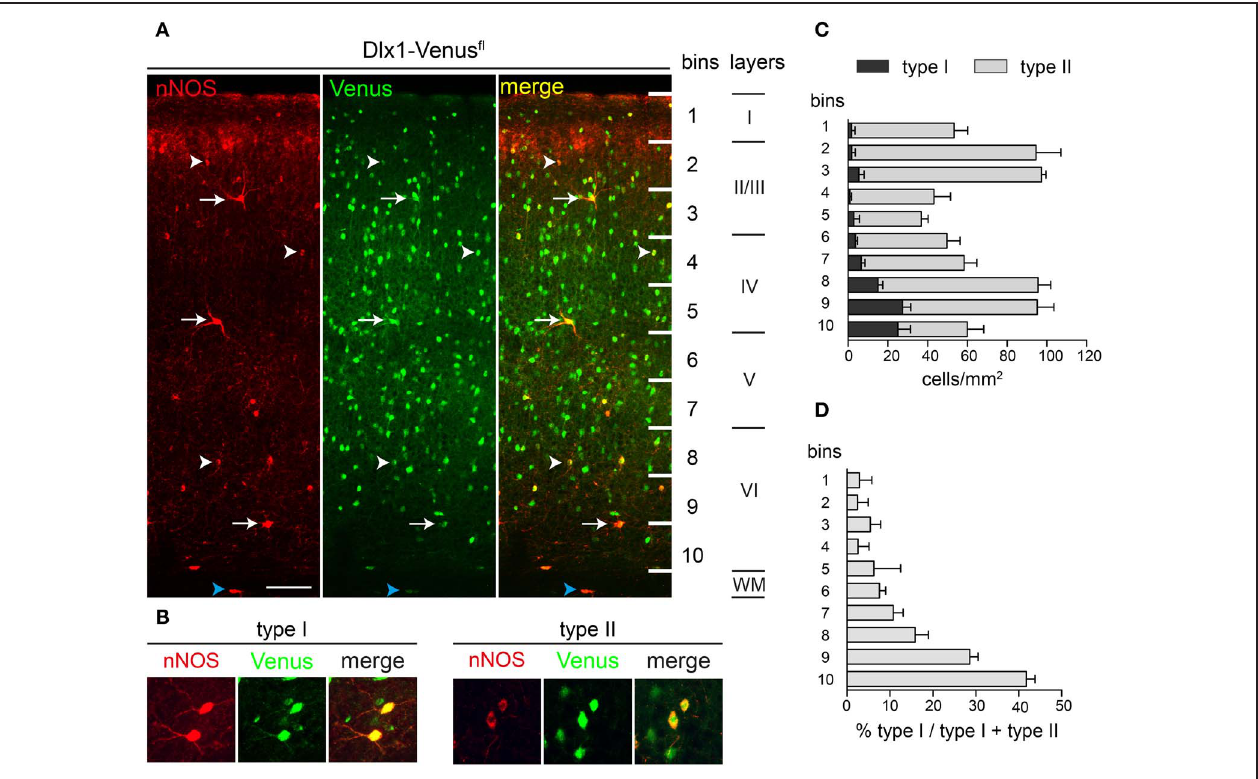
FIGURE 3 | nNOS-expressing type I and type II cells in the adult somatosensory cortex. (A) nNOS and Venus expression in the somatosensory cortex of Dlx1-Venus fl mice. Arrows and arrowheads point to type I and type II cells respectively. Blue arrowheads mark nNOS-expressing cells in the white matter (WM). (B) High magnification images of type I and